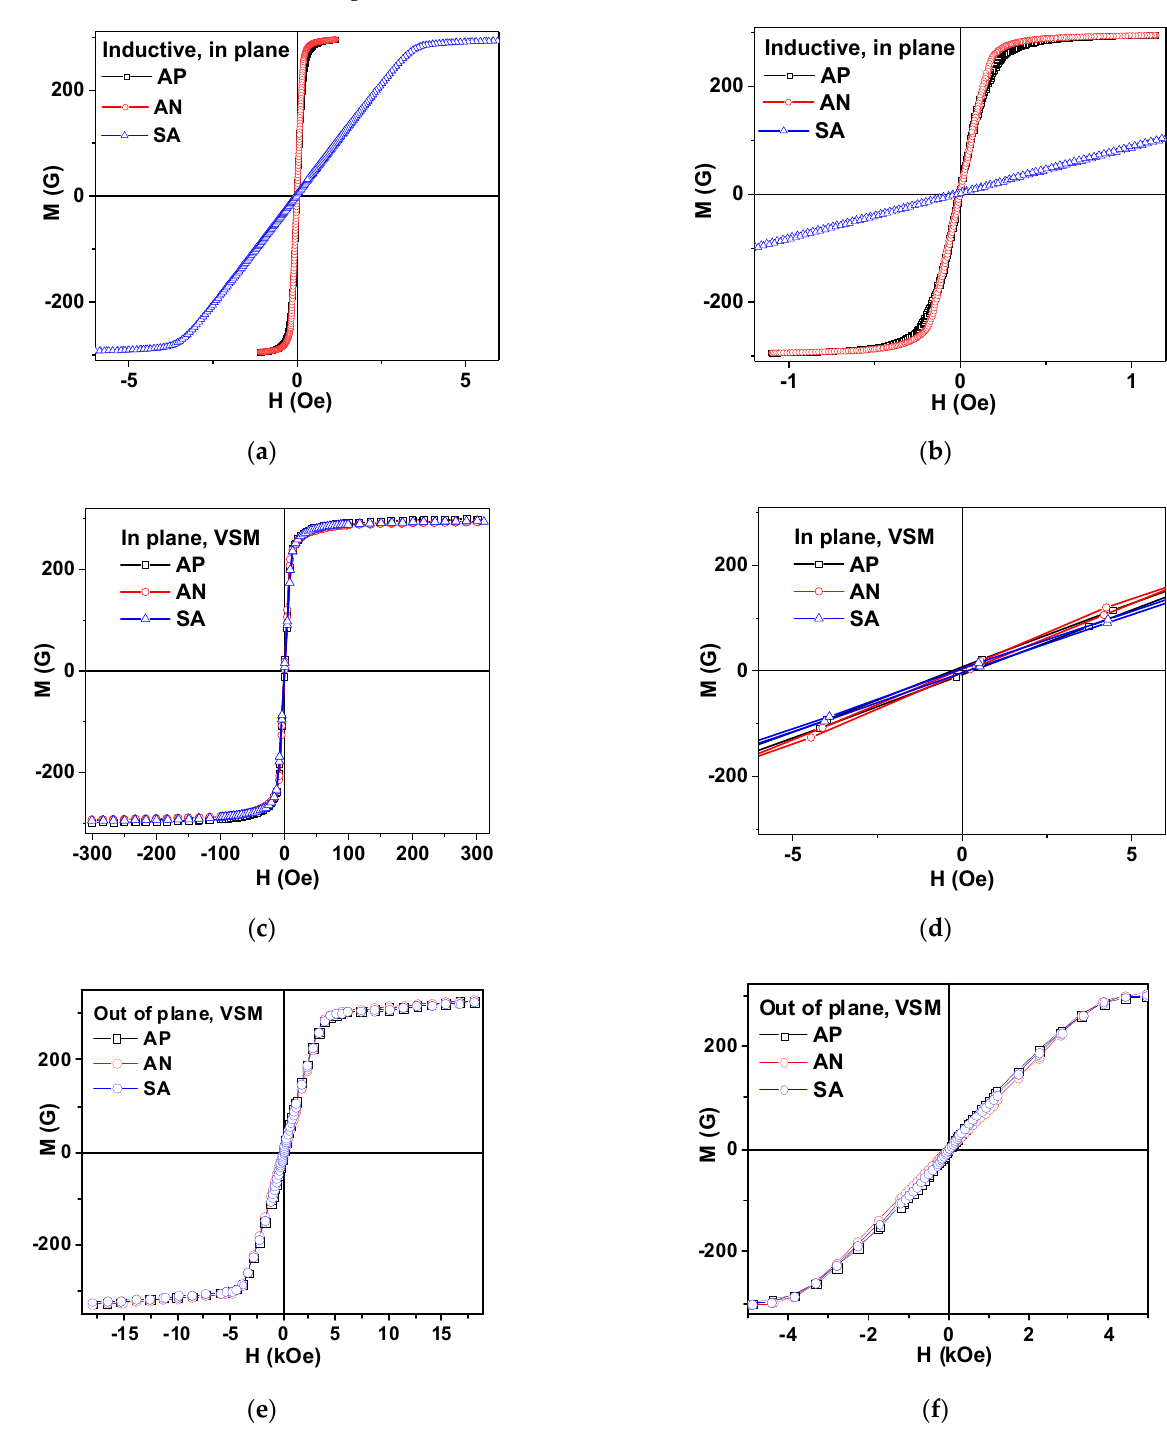
Figure 4. Magnetic hysteresis loops of amorphous Fe 3 Co 67 Cr 3 Si 15 B 12 ribbons in different states, with AP, AN and SA measured by: inductive technique ( a , b ); by VSM in the plane of the sample ( c , d ); and out-of-plane of the sample ( e , f ). For inductive measurements, sample length was l = 45 mm and for VSM samples, the length was l = 5 mm.